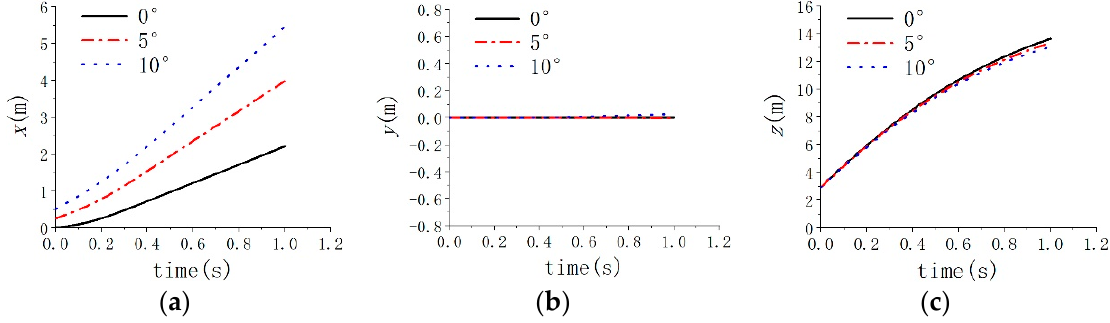
Figure 8. Centroid coordinates of vehicle in case 4, 5, 6. ( a ) Vehicle centroid X -axis coordinates. ( b ) Vehicle centroid Y -axis coordinates. ( c ) Vehicle centroid Z -axis coordinates.